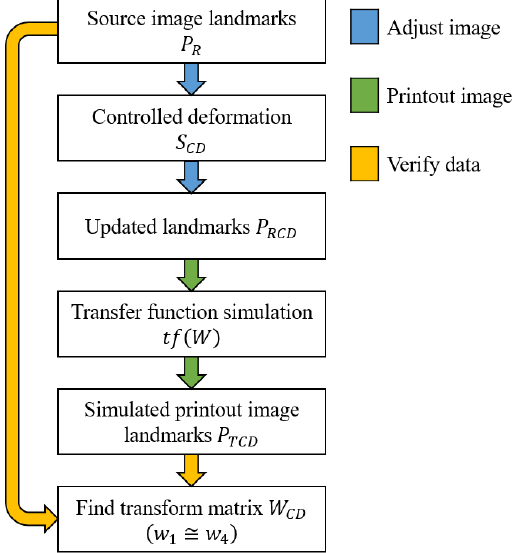
Figure 15. Calibration process validation.